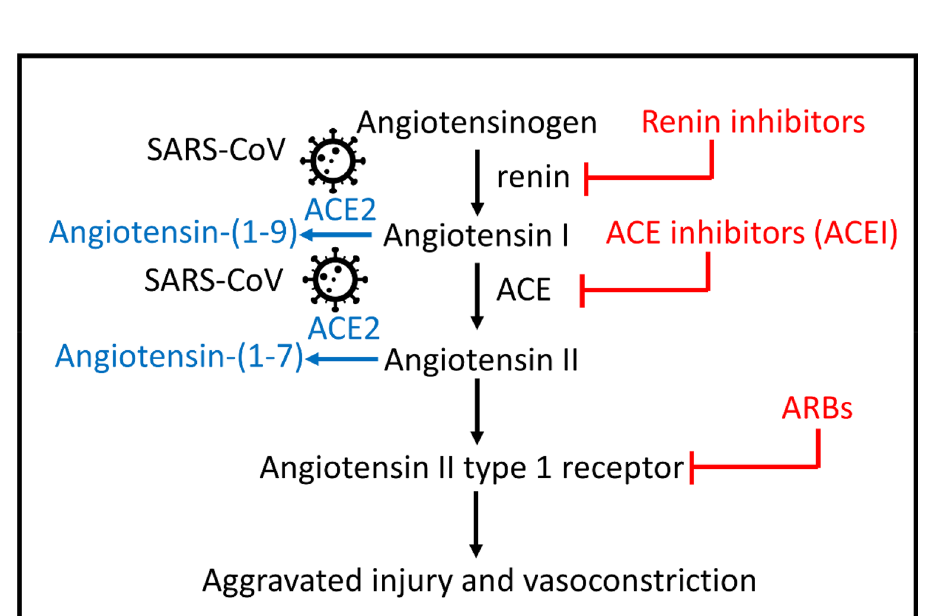
Figure 1. The RAAS pathway and its relationship to SARS-CoV(1 and 2) viruses. Upon entry to cells, the SARS-CoV is known to bind to its functional receptor, angiotensin converting enzyme 2 (ACE2). In normal physiology, renin cleaves angiotensinogen, produced by the liver which yields angiotensin I. The angiotensin converting enzyme (ACE) converts angiotensin I to angiotensin II and the angiotensin II binds to the angiotensin II type 1 receptor which leads to vasoconstriction, aggravated tissue injury and hormonal production. ACE2 cleaves angiotensin II into angiotensin (1–7) to attenuate the effects of vasoconstriction. Another function of ACE2 involves cleaving angiotensin I to angiotensin-(1–9) for the hydrolysis of peptides such as apelin-1. Aliskiren is a direct renin inhibitor that blocks the conversion of angiotensinogen